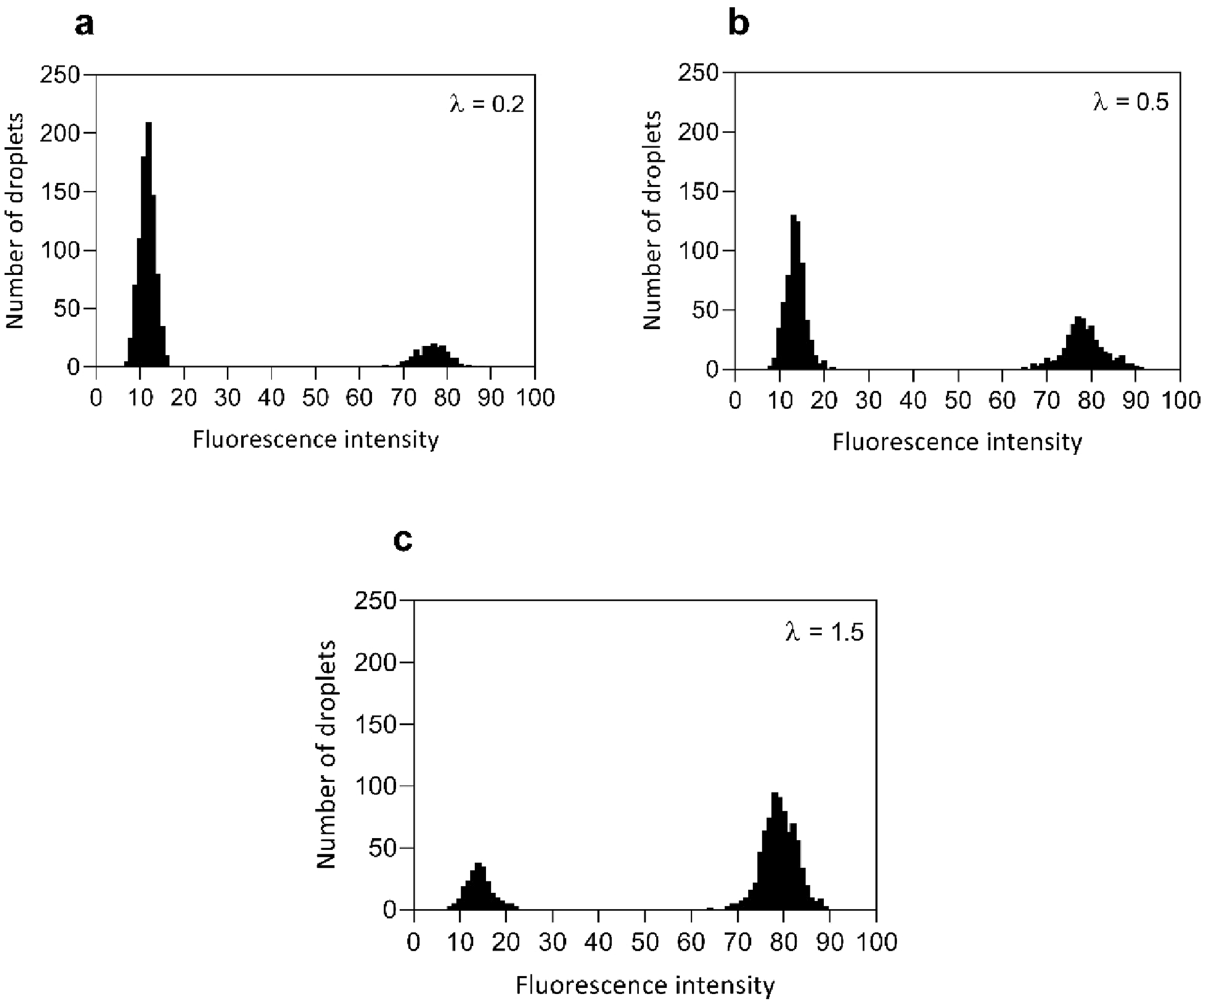
Figure 8. Histograms of fluorescence intensity values for over 1000 droplets at ( a ) λ = 0.2, ( b ) λ = 0.5, and ( c ) λ =